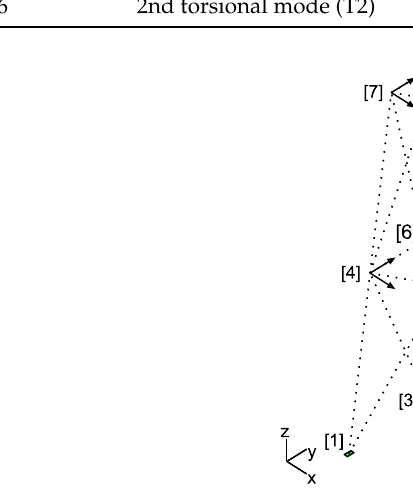
Figure 13. Sensors and measured